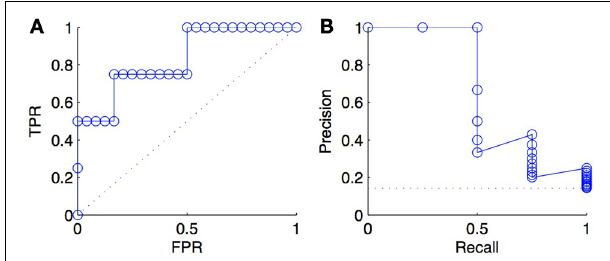
FIGURE 3 | ROC curve (A) and PR curve (B) for a list of scores where negative examples were tripled with respect to scores of Figure 2. The comparison with the curves in Figure 2 shows that the ROC curve is unchanged and that the PR curve degrades, as a consequence of tripling the